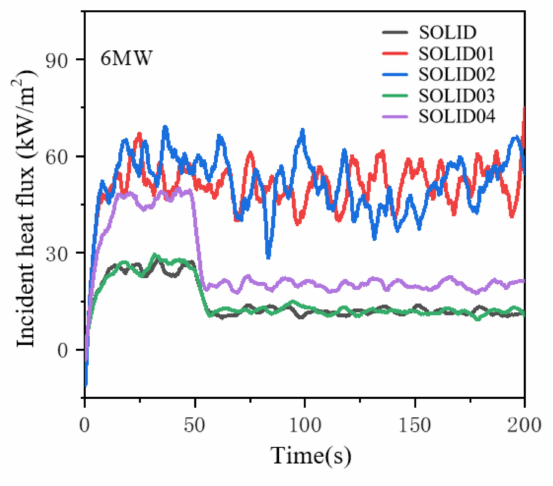
Figure 31. The change of the incident heat flux of the glass under the action of the window